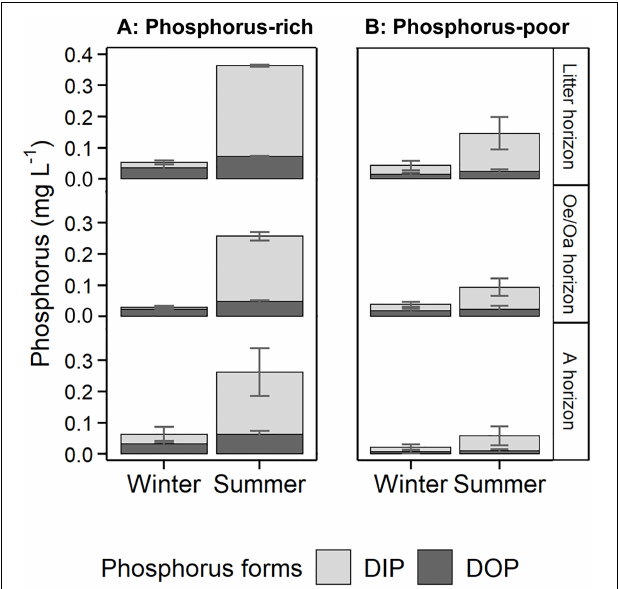
FIGURE 1 | Phosphorus (P) concentrations in leached soil solutions from unfertilized litter, Oe/Oa, and A horizons in Winter 2019 and Summer 2019 at (A) the P-rich site Bad Brückenau (BBR) and (B) the P-poor site Lüss (LUE). Data averaged ( n = 3). DOP, dissolved organic P; DIP, dissolved inorganic P.